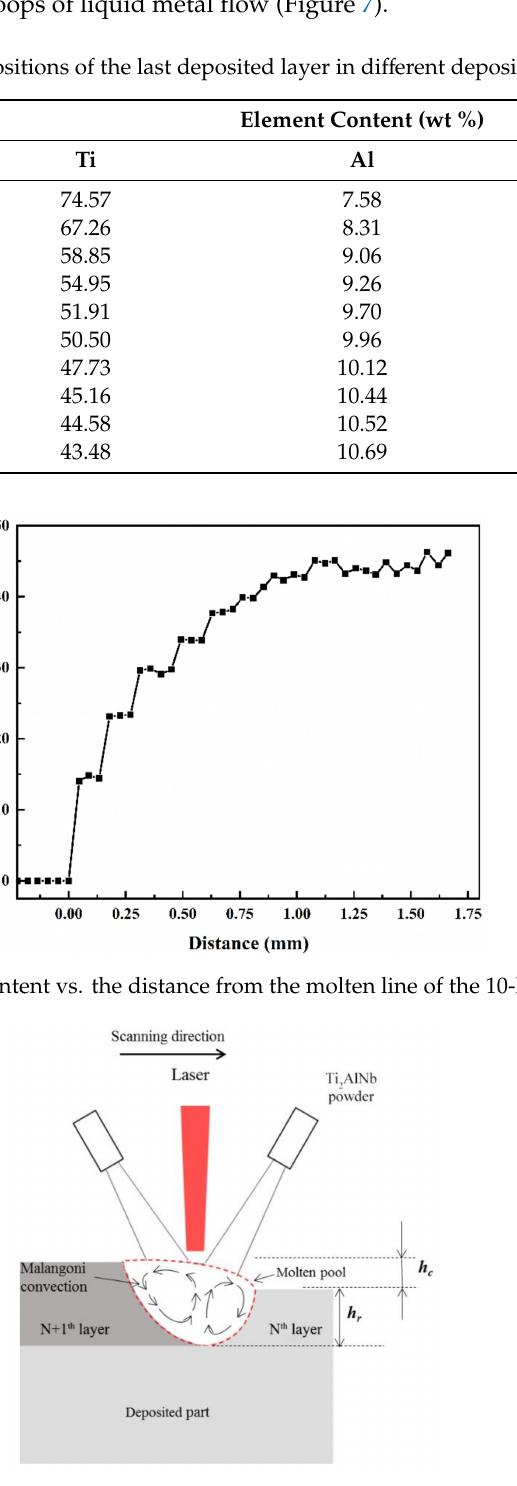
Figure 7. The schematic of the dilute e ff ect in the molten